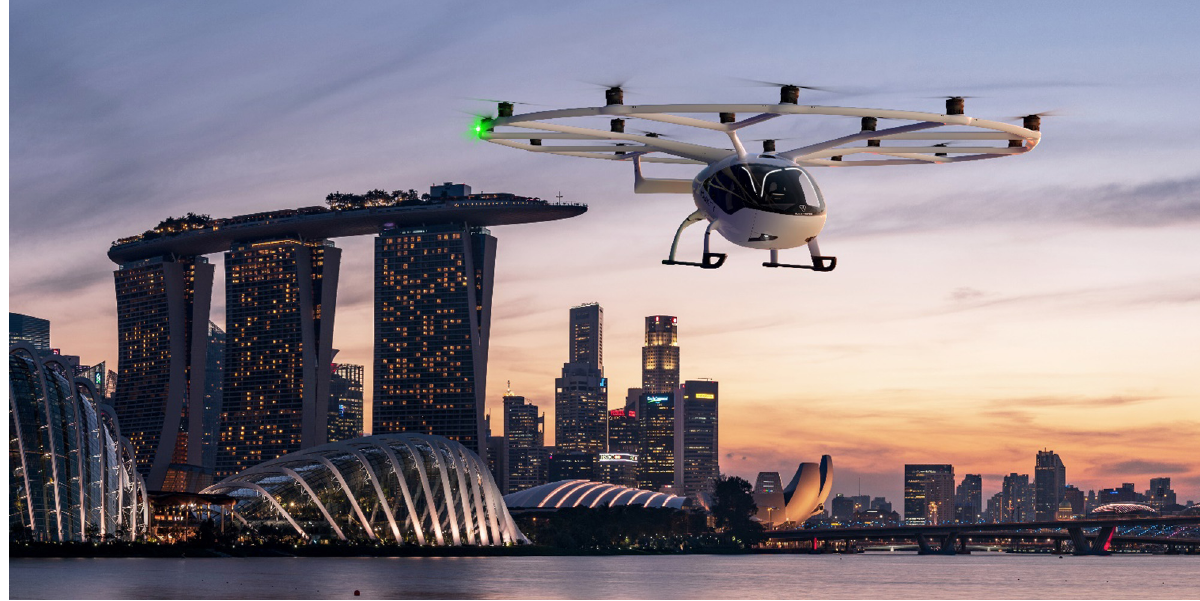
Figure 5: A rendering for Volocopter ’ s VoloCity while fl ying over Singapore ( image credit: Volocopter GmbH, License ( s ) : Zur freien Verwendung – for free use, used with permission ) .